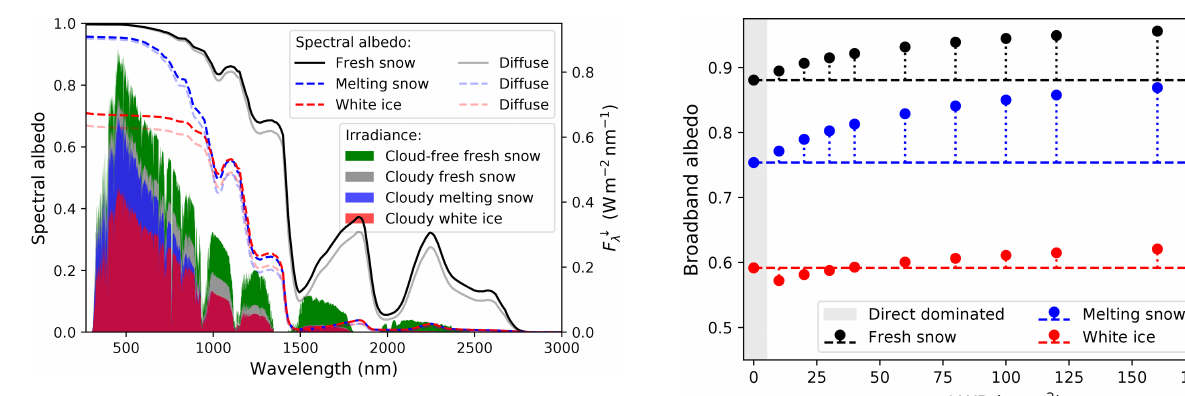
Figure 3. Simulated spectral snow albedo of three seasonal sea ice types generated using different SSA and snow thickness values (specified in the main text) above sea ice with a spectrally neutral albedo of 0.5. Non-attenuated lines show the albedo of the cloud- free situations (SZA of 65 ◦ ), and attenuated lines (transparent col- ors) represent the albedo for overcast/diffuse conditions (color re- lated). The downward irradiance (right y axis) simulated for these cases is shown by the shaded areas. Green shows the cloud-free spectra over fresh snow, and gray, blue, and red show the spectra under cloudy conditions (LWP of 80gm − 2 ) for the surface albedo related by the colors.